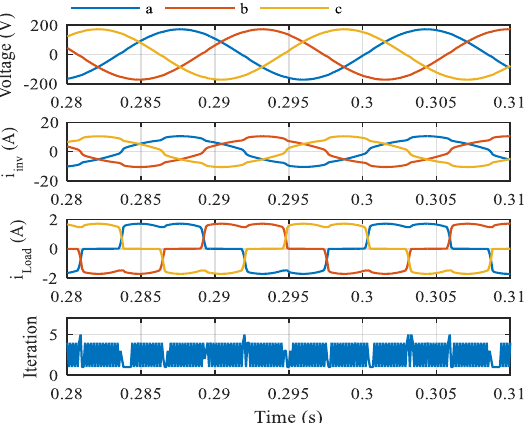
Figure 8. Performance of the proposed model predictive control (MPC) in the condition of nonlinear load.